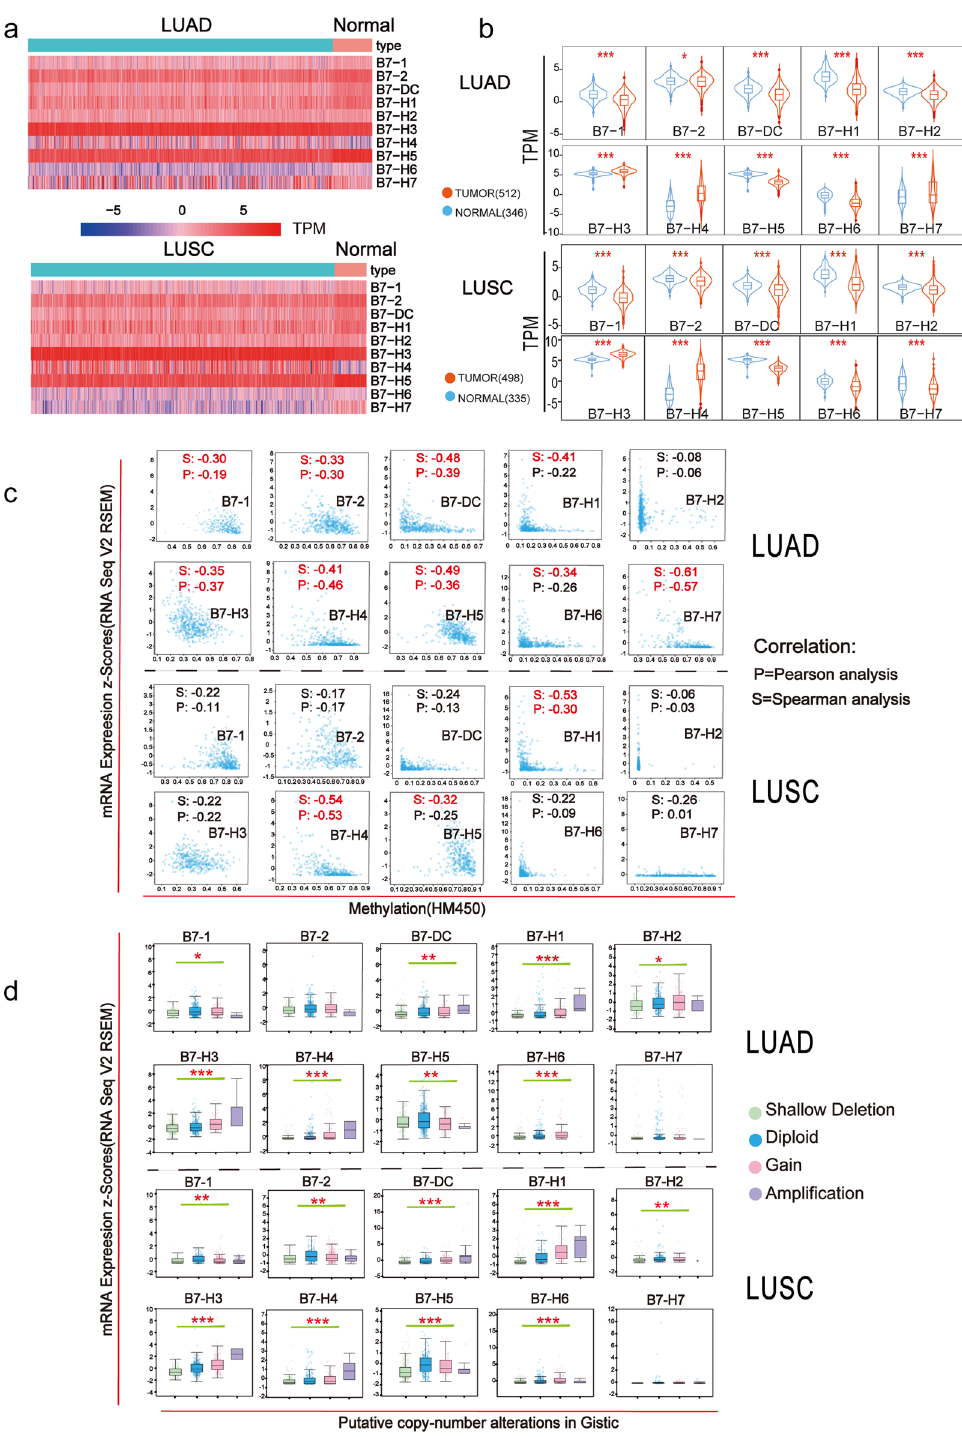
Figure 1. Altered expression and underlying mechanism of B7 family in different subtypes of NSCLC. ( a ) The expression profile of B7 family was displayed in heatmap in normal and tumor tissues of different NSCLC patients with data extracted from TCGA database. ( b ) The violin plots showed the average expression level of B7 family members in normal and tumor tissues based on TCGA and GTEX data. Expression level is mapped by Transcripts Per Kilobase of exon model per Million mapped reads (TPM). (LUAD:512 tumor samples and 347 normal samples; LUSC:498 tumor samples and 336 normal samples). ( c ) Correlation between promoter DNA methylation and the expression of B7 family. ( d ) The relationship between expression and copy numberstatus of B7 family members (* P < 0.05; ** P < 0.01; *** P <